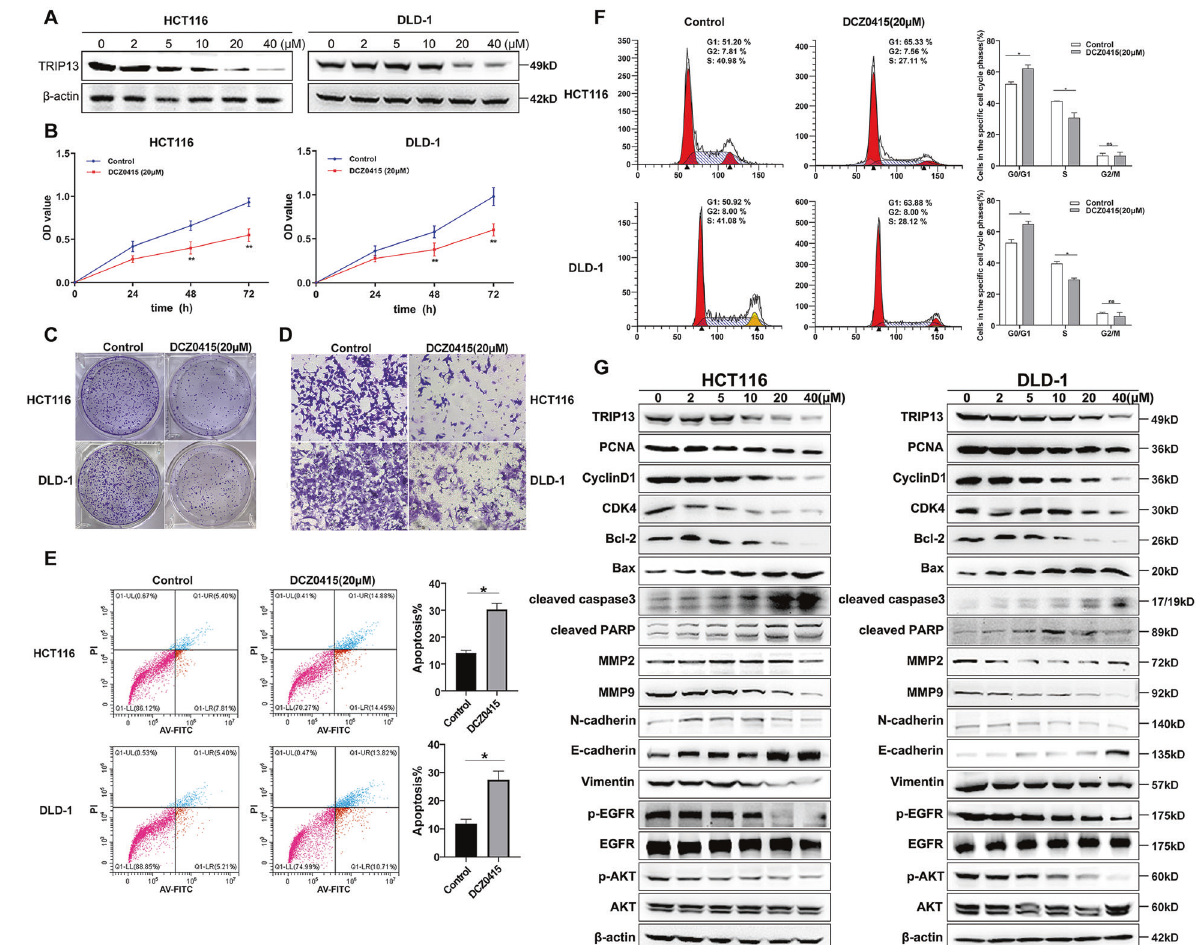
Fig. 5 DCZ0415 suppressed CRC cell proliferation, invasion as well as migration, promoted cell apoptosis, and resulted in the arrest of cell cycle. A DCZ0415 decreased the expression of TRIP13 in CRC cells. B DCZ0415 inhibited cell proliferation of CRC cells. C DCZ0415 signi fi cantly reduced number of cell colonies. D DCZ0415 suppressed invasion and migration of CRC cells. E DCZ0415 increased apoptosis of CRC cells. F DCZ0415 induced G0/G1 phase arrest of CRC cells. G The protein level of PCNA, Bcl-2, Cdk4, Cyclin D1, MMP2,